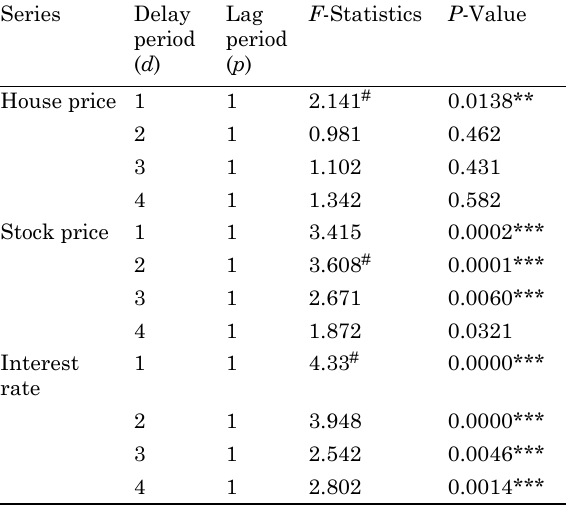
Table 6. Linear test and section d